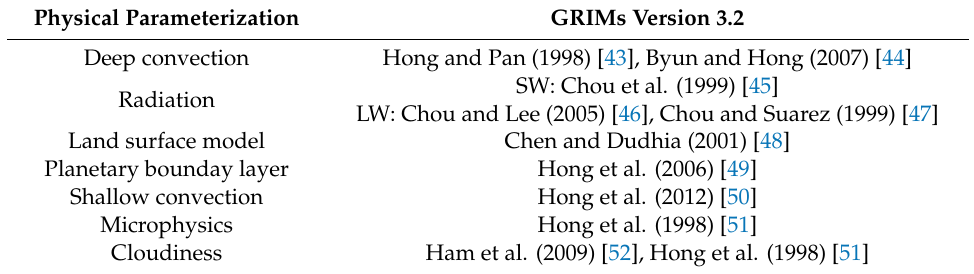
Table 1. Global / Regional Integrated Model System (GRIMs) physics packages version